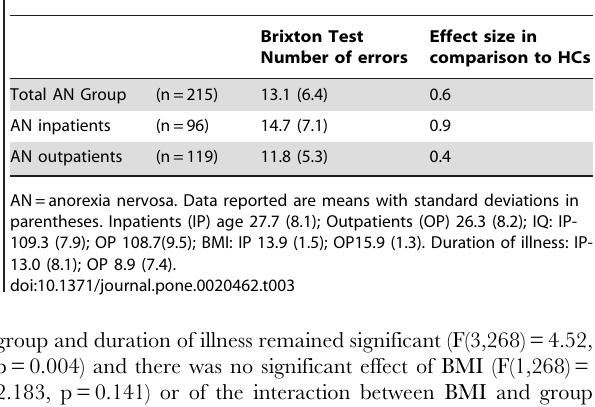
Brixton Test Number of errors